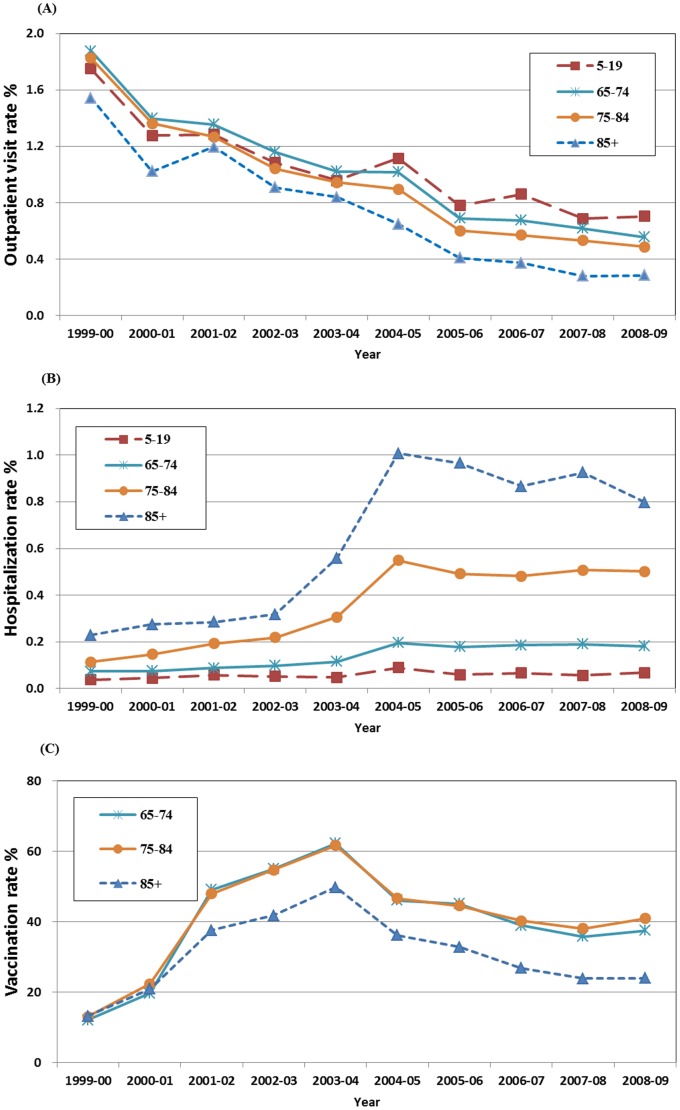
Age-specific event rates over the study period from 1999–2000 to 2008–2009 influenza seasons in Taiwan.Panel A and Panel B represents pneumonia and influenza (P&I)-related outpatient visit and hospitalization rates. Panel C represents the annual trivalent influenza vaccine (TIV) vaccination rate in percentage.